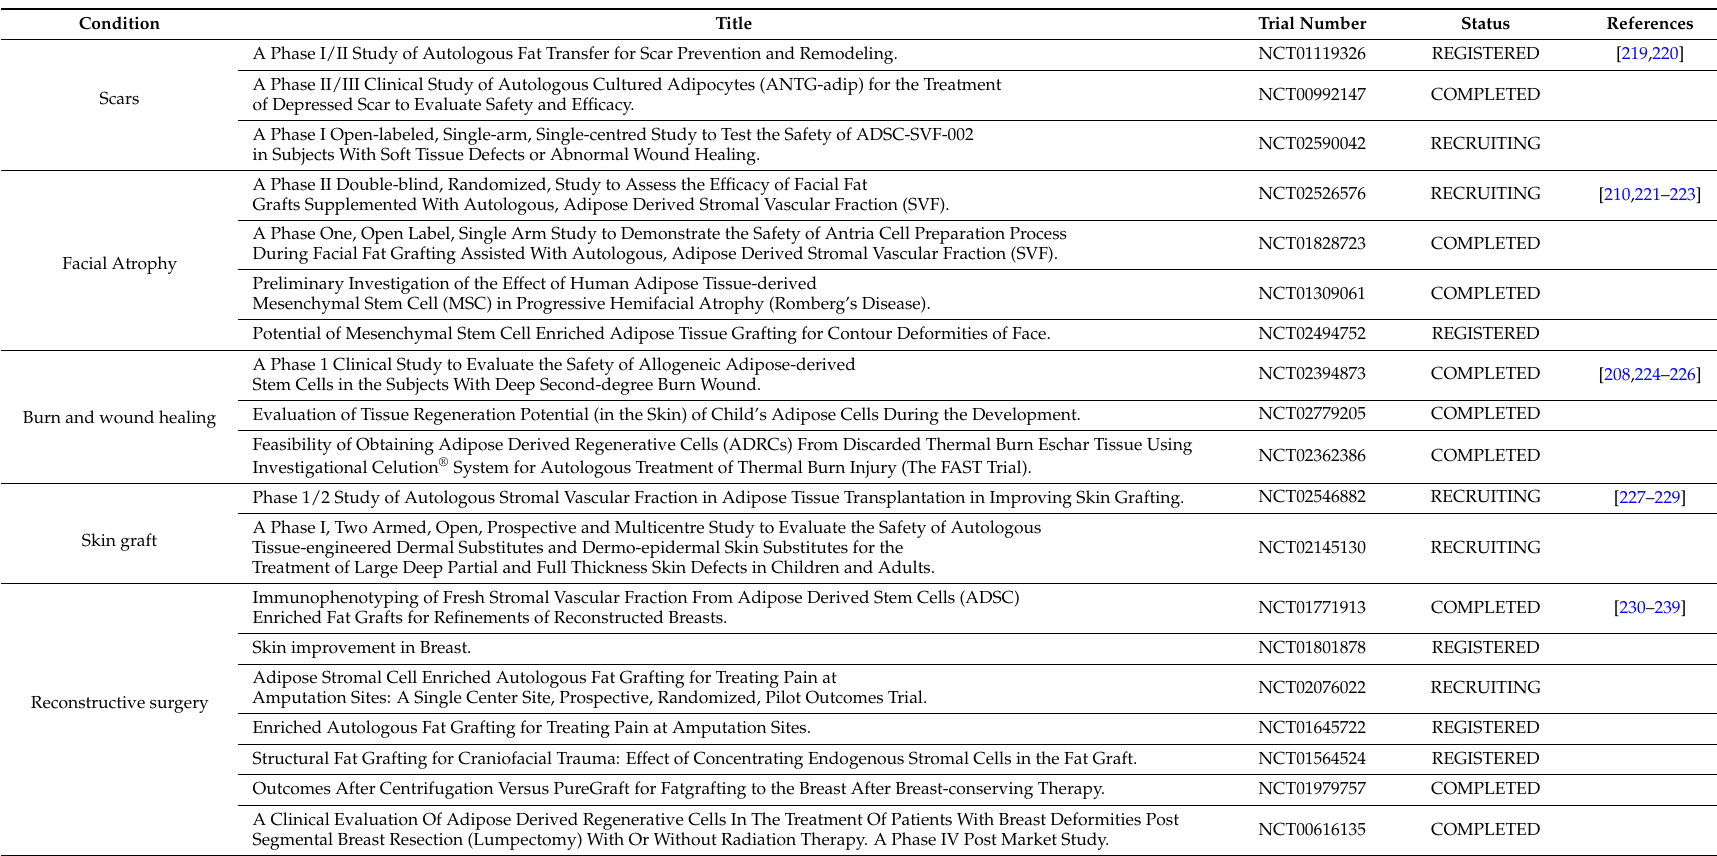
Table 2. ADSCs in Clinical Trials for Dermatological